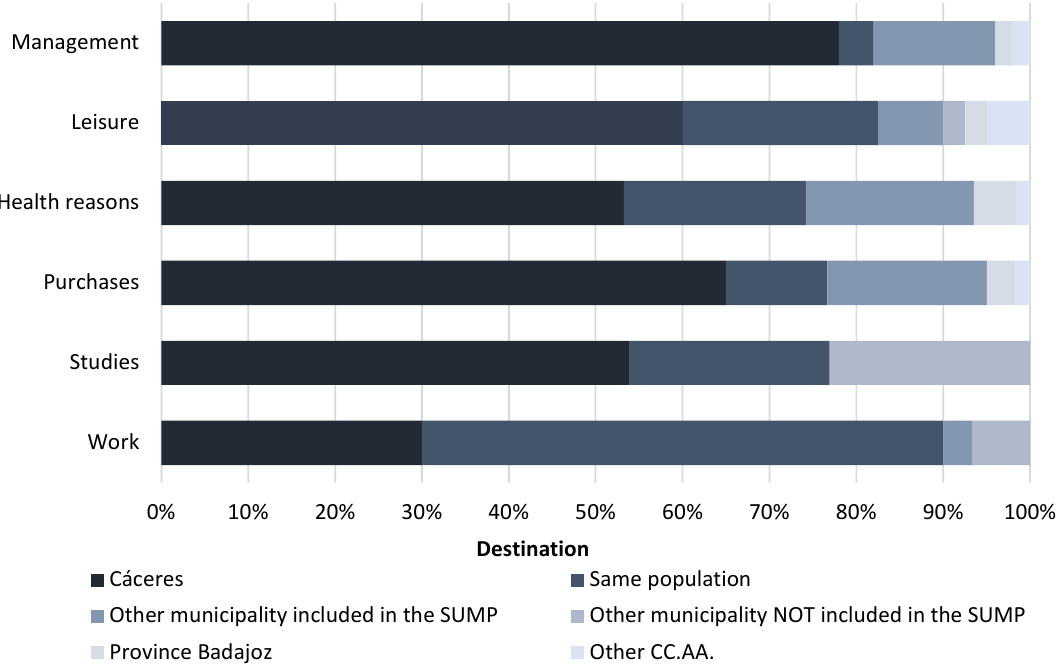
Figure 9. Destination of journeys of municipalities with a population of less than 500 inhabitants according to reason.